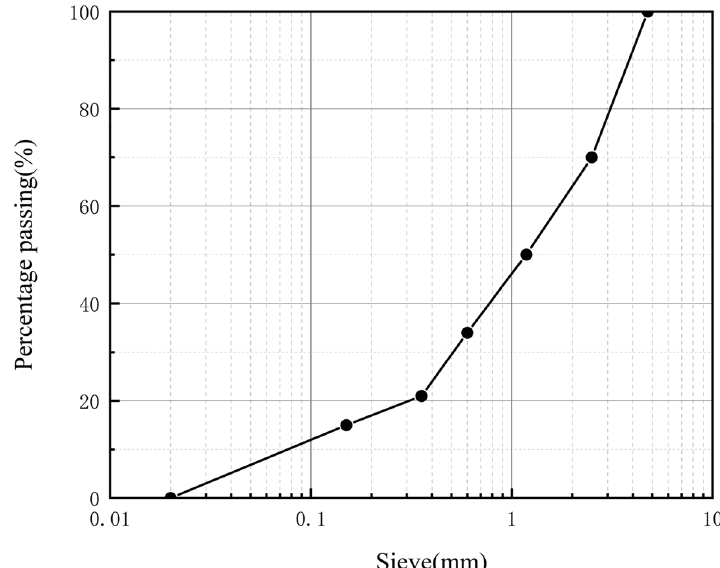
Fig. 3 Gradation curve of the sand